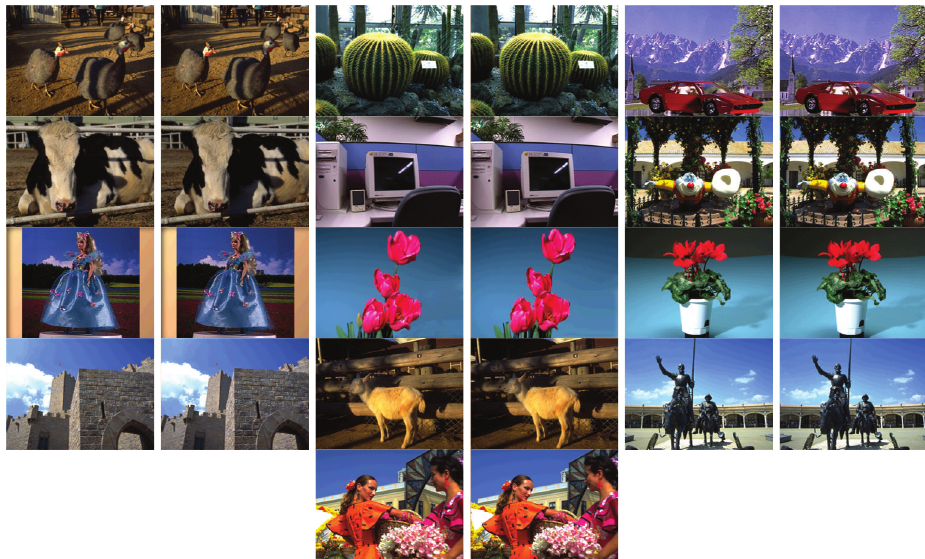
Figure 6: Reference stereoscopic images in the Toyama database [3]: bird, cactus, car, cattle, computer, doll, doll2, flower, flower2, gate, goat, statue, and women in turn.